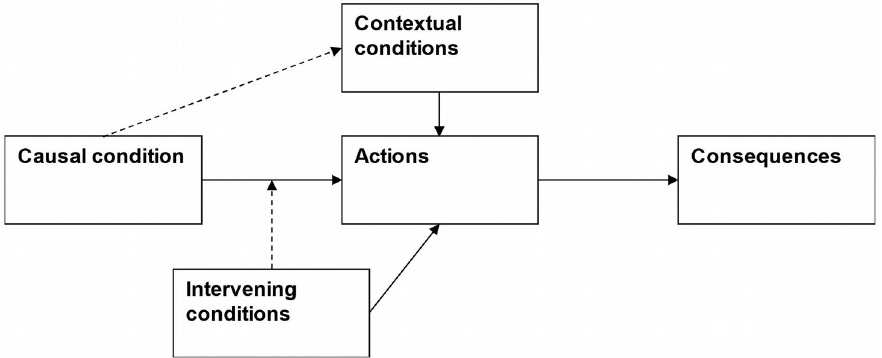
Figure 2. The paradigm scheme of